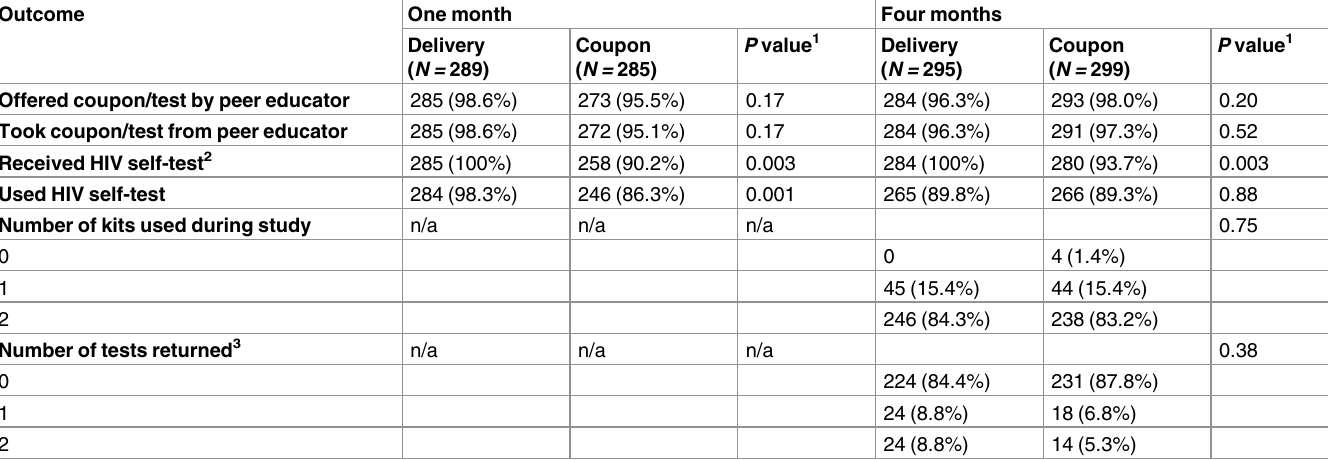
Table 3. HIV self-test kit distribution and use at 1 and 4 months by study